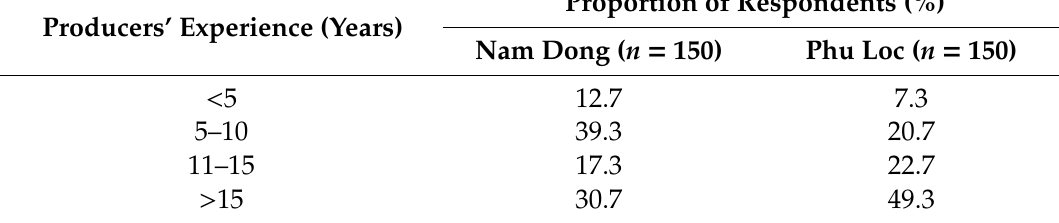
Source: Field research (2018,